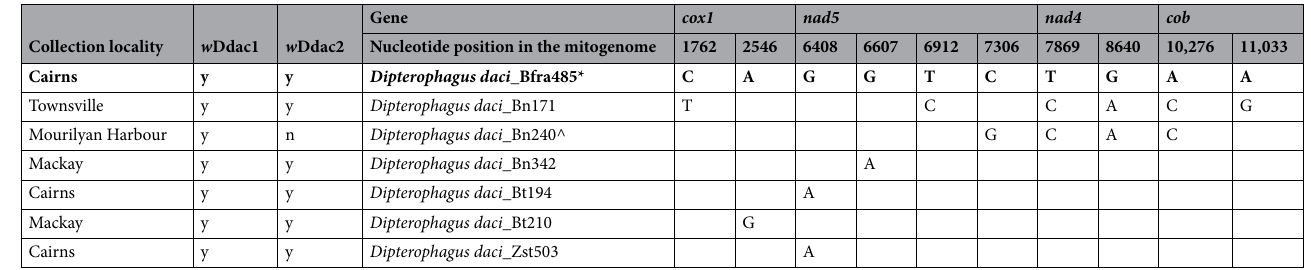
Table 2. Single nucleotide polymorphisms (SNPs) in protein coding genes of Dipterophagus daci mitogenomes, showing the collection locality, Wolbachia infection status (+ or −) with w Ddac1 (ST-285) and w Ddac2 (ST-289) and the SNP position in the mitogenome; * denotes the assembled reference mitogenome of D. daci from Bactrocera frauenfeldi Bfra485 (MW233588) and ^ denotes the library with low coverage that did not allow assembly of the mitogenome; empty cells indicate that the positions have the same nucleotide as the assembled reference genome.